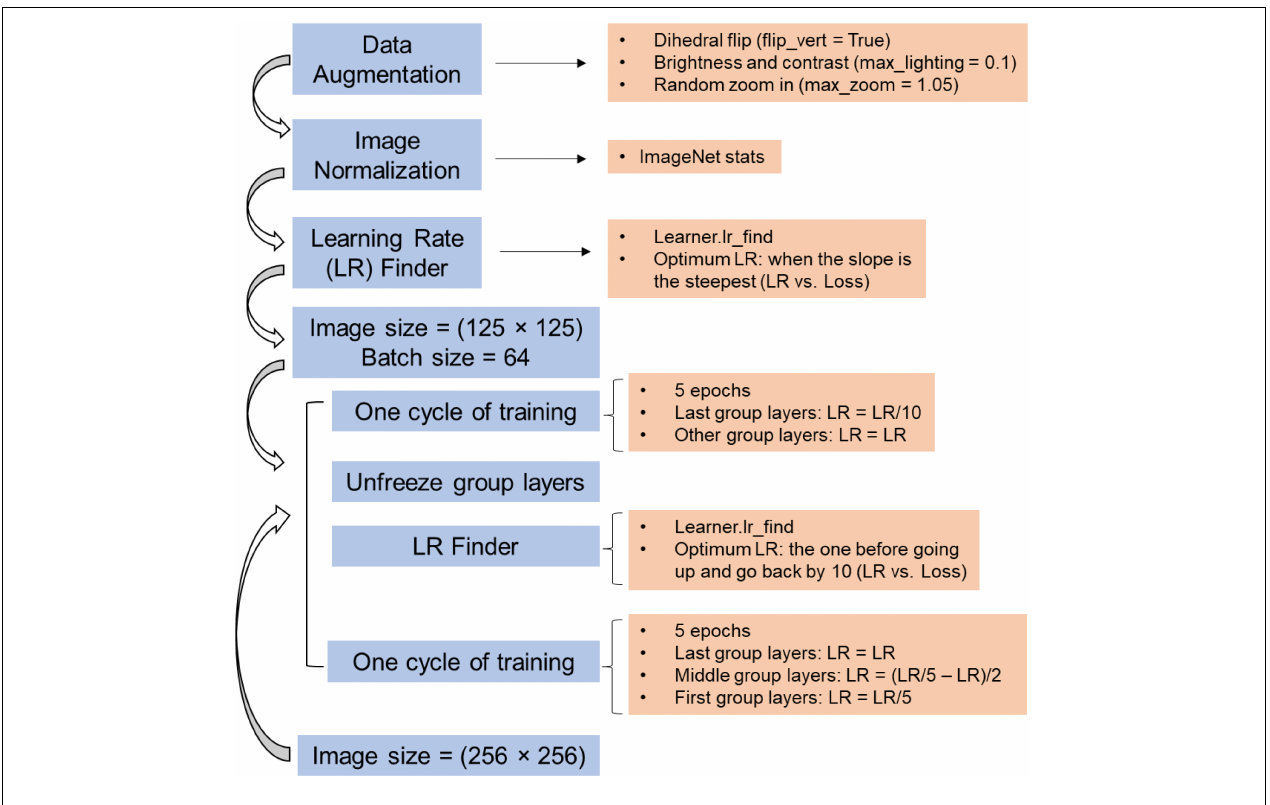
FIGURE 2 | Schematic workflow for training image classifier in Fastai.